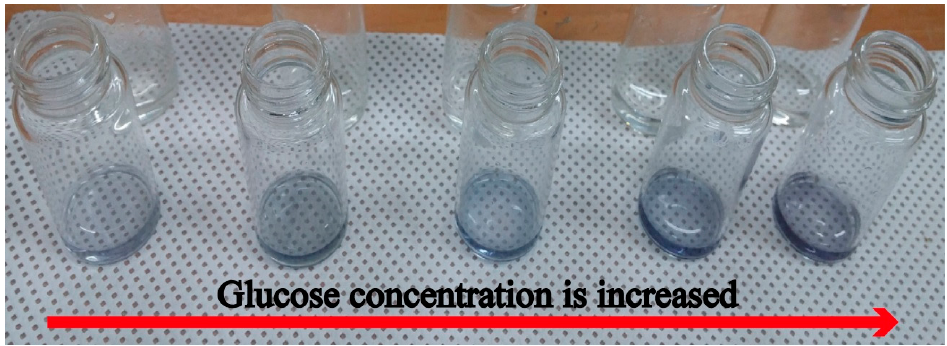
Figure 10. Change of color density as a function of glucose concentration.